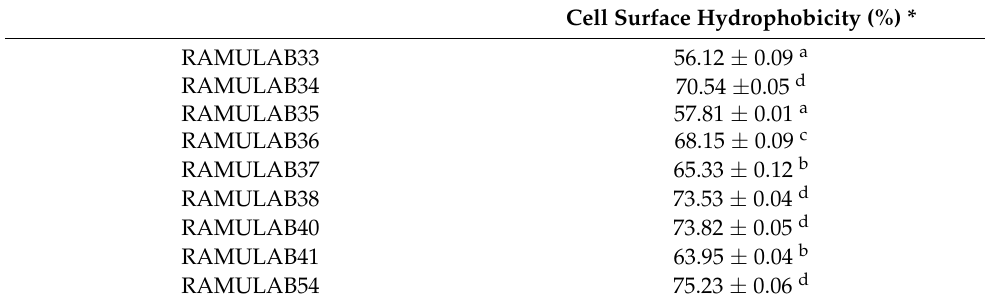
Table 4. Cell surface hydrophobicity of fermented sugarcane juice